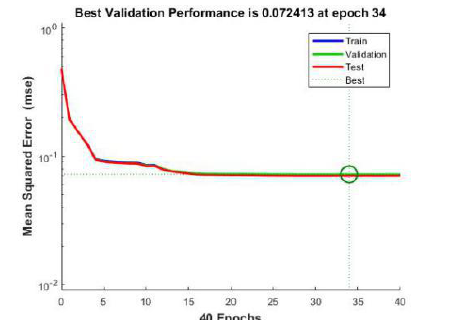
Figure 4. The plot of MSE in each epoch when training the pilot area